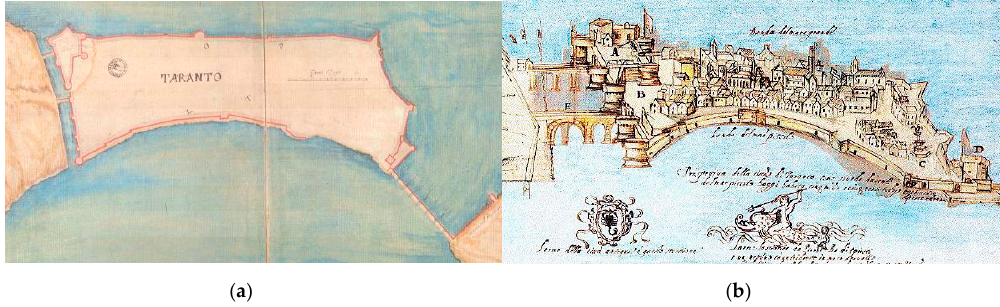
Figure 3. Iconographic maps of the fortifications of the city of Taranto (the north is downwards): ( a ) cartography of the second half of the XVI century and ( b ) reconstruction of the city of Taranto seen from the Mar Piccolo in the XVI century.